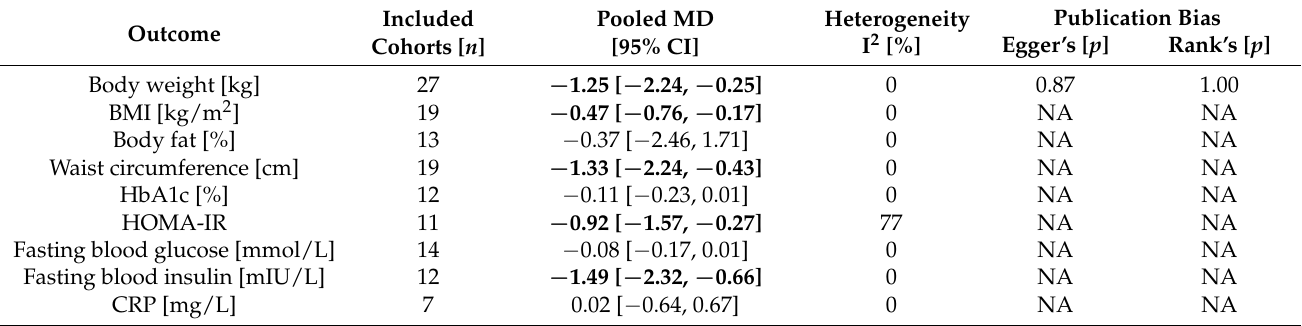
Table 2. Pooled mean difference and CI, heterogeneity I 2 , and publication bias of included cohorts.